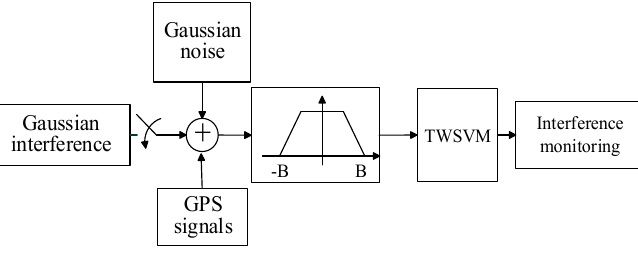
Figure 2. Experimental scheme of the interference monitoring.